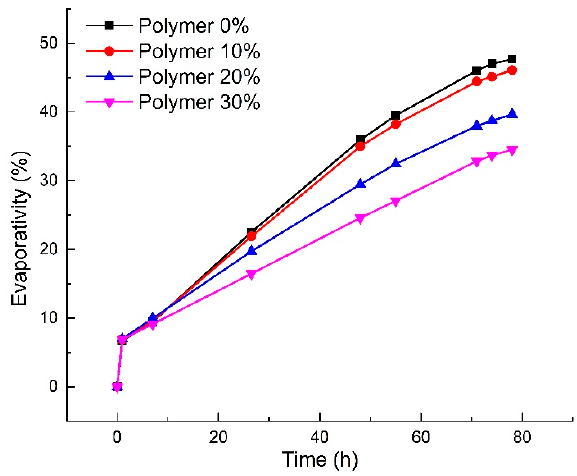
Figure 5. The water retaining vs. time on samples S1–S4.